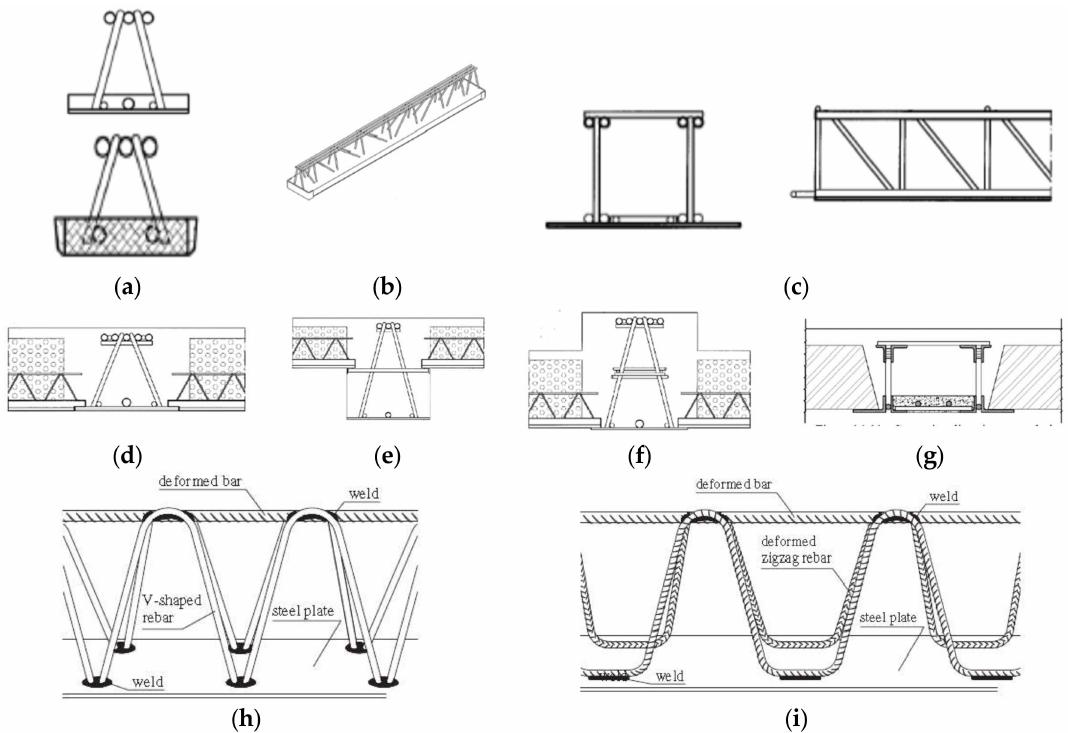
Figure 1. Beams having: ( a ) steel or precast prestressed concrete bottom chords; ( b ) spatial lattices; ( c ) multiplane lattices; ( d – f ) slab thick downward, and upward (compared to the slab) full thick beams; ( g ) bottom chord made by steel angular; ( h ) web made by a single bar bent with a V shape; or ( i ) consisting of a continuous serpentine.